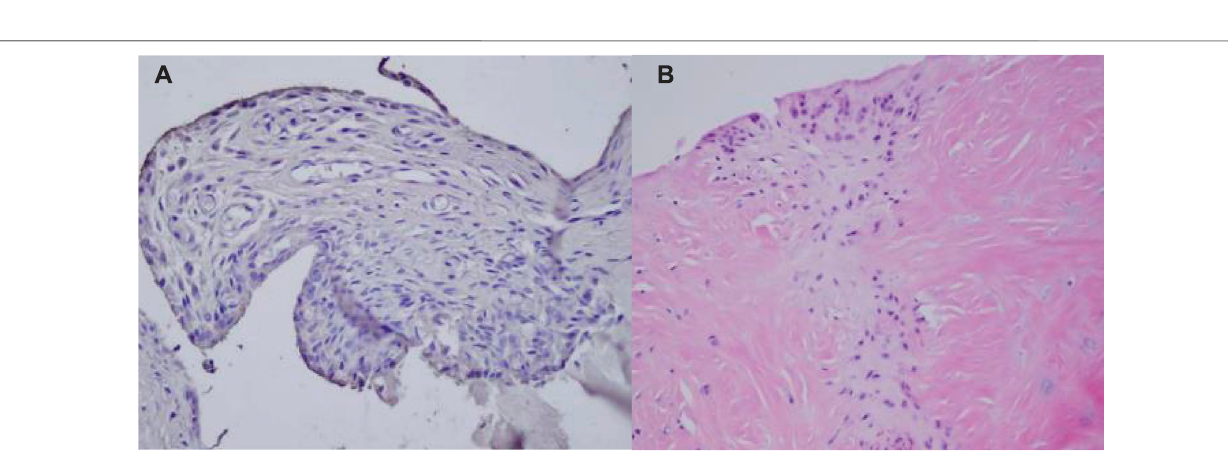
FIGURE 11 | Histological observation 6 weeks after surgery (The picture is from my experiment).